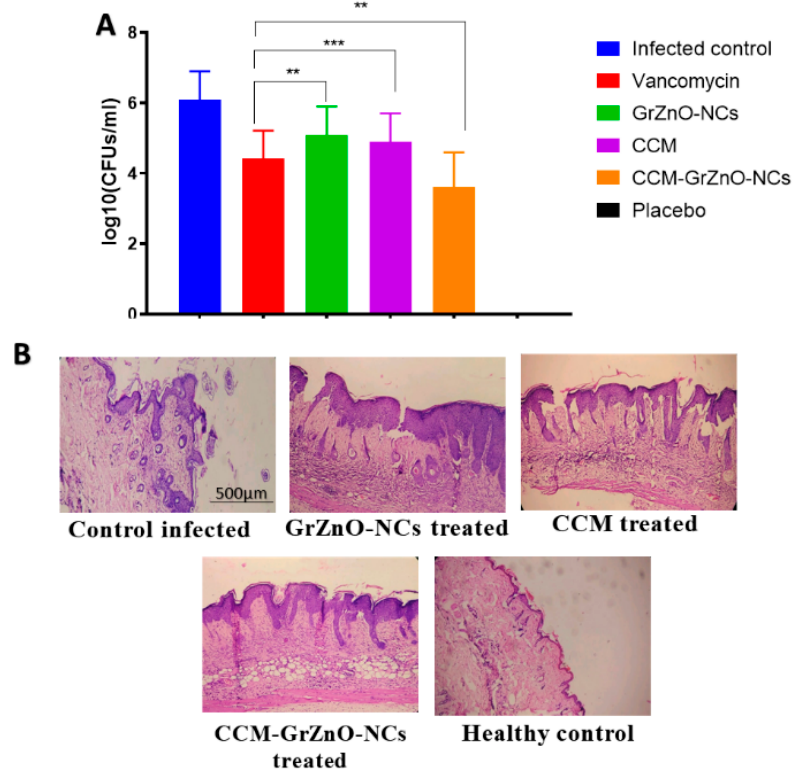
Figure 9. Effect of CCM-GrZnO-NCs formulations on experimental M.R.S.A. skin infection in Balb/C mice . ( A ) Efficacy of CCM-GrZnO-NCs against M.R.S.A. skin infection in experimental animals. Mice